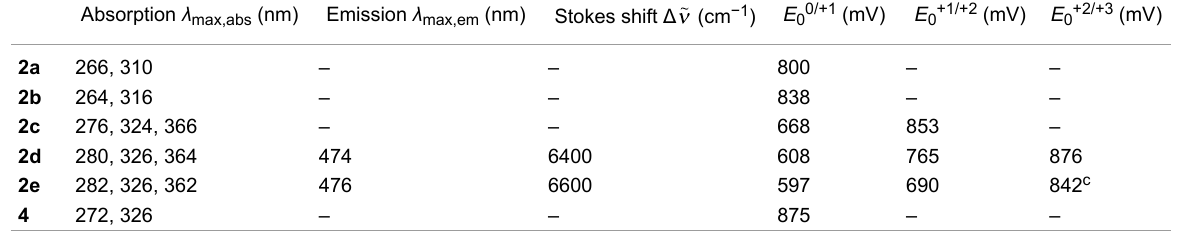
Table 1: Selected electronic properties of (oligo)phenothiazinyl thioacetates 2 and 4 (absorption a and emission spectra a and cyclic voltammetry b ).